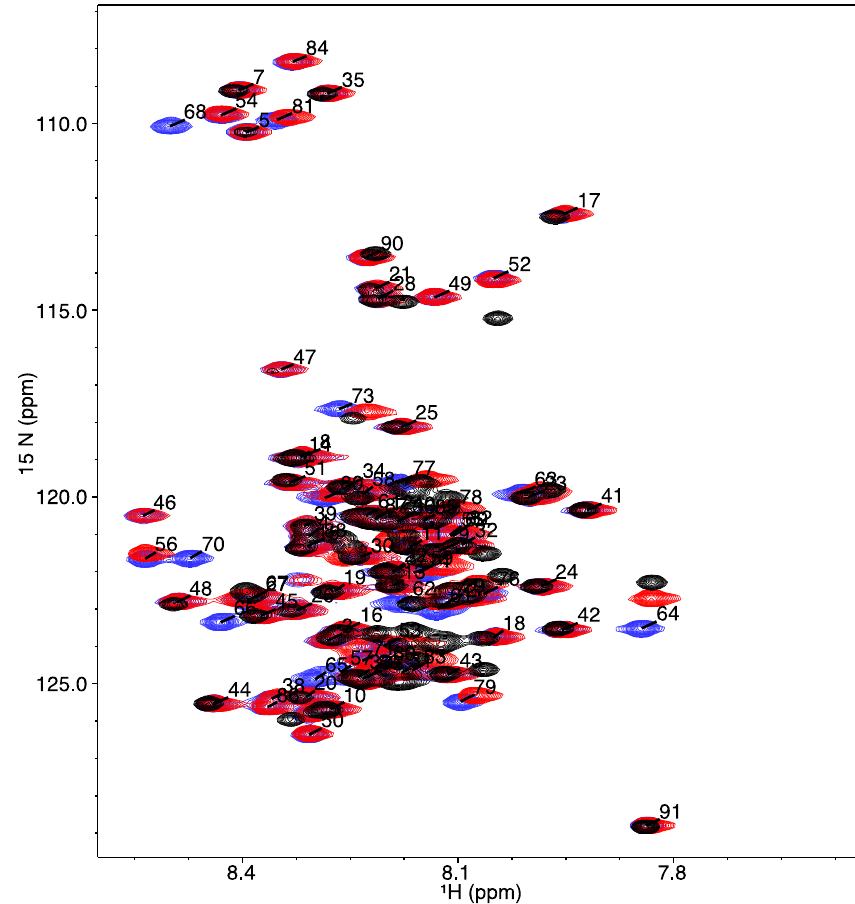
Figure 3. 1 H- 15 N heteronuclear single quantum coherence nuclear magnetic resonance (HSQC NMR) spectra for COR15A WT and mutants in the absence of trifluoroethanol (TFE). The blue peaks depict the WT protein, the red peaks indicate the single mutant G68A and the quadruple 4GtoA mutant is represented by the black peaks. The peaks are labelled with the residue-specific assignments for the WT protein.